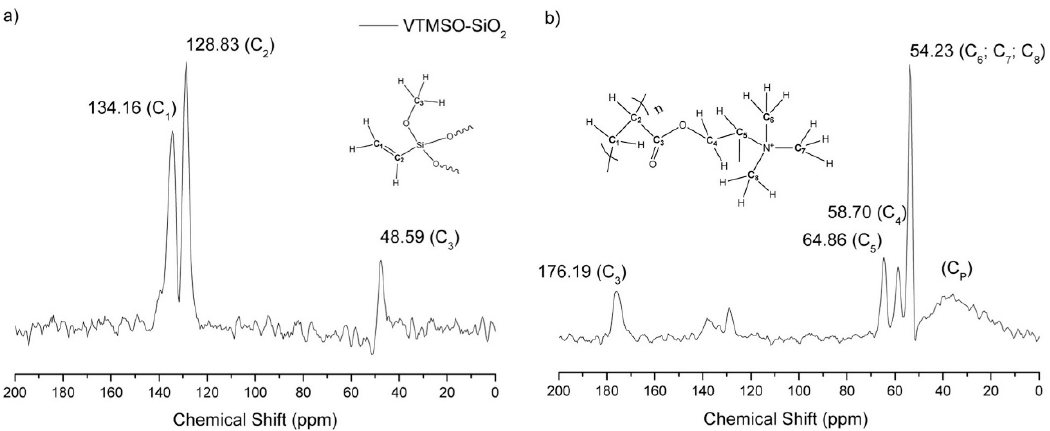
Figure 2. Solid-state 13 C NMR spectrum of VTMSO-SiO 2 ( a ) and Q/VTMSO-SiO 2 ( b ). Inset: structure details with signal assignment.